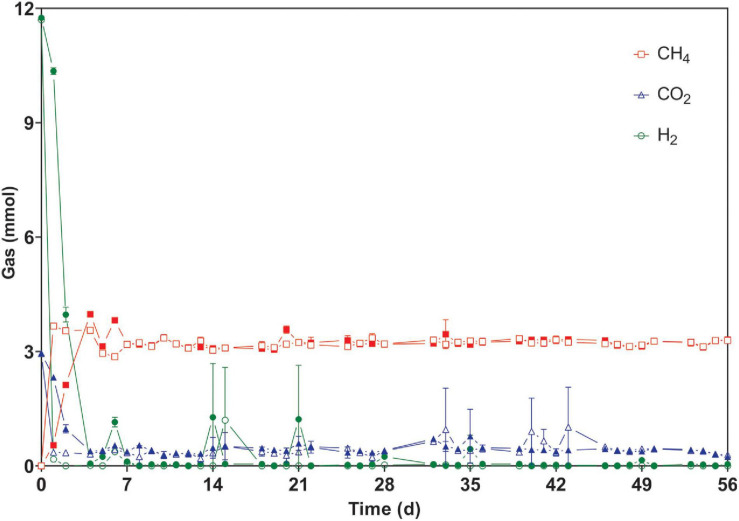
Time course of consumed and produced gases during regular fed-batch operation (phase 1). The bottles were fed every 24 h (except weekends) and measurements were carried out at the end of each batch cycle. Open symbols: reactors WW (inoculated with anaerobic granular sludge from an industrial-scale UASB reactor treating wastewater from paper industry); filled symbols: reactors PF (inoculated with digestate from a pilot-scale plug flow reactor digesting cow manure and corn silage). The mean and standard deviation of n = 4 are depicted. Invisible error bars are smaller than the symbol.